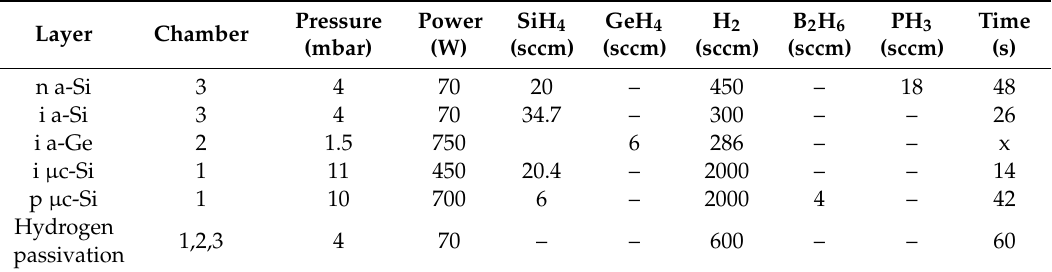
Table 1. Detailed PECVD process parameter for the ultrathin a-Ge:H solar cell. The deposition time for the germanium layer is x = 500 or 1000 s for approximately 5 or 10 nm,